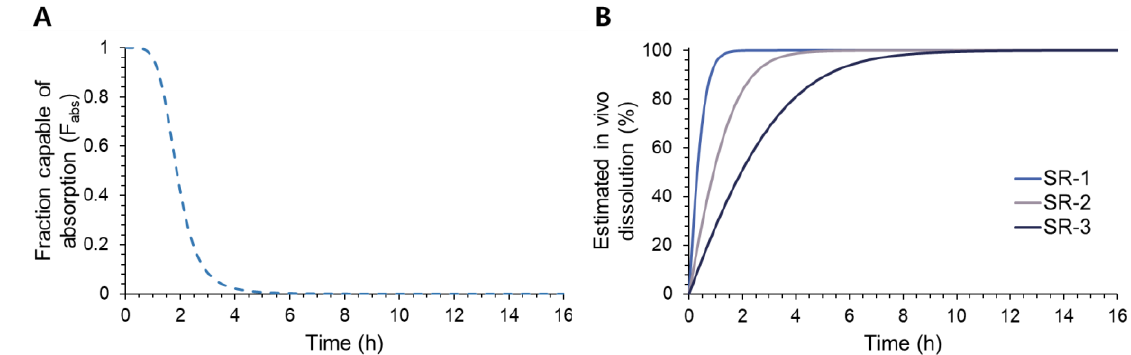
Figure 5. Changes in the fraction capable of absorption (F abs ) of donepezil ( A ) and the in vivo dissolution profiles of SR-1, SR-2, and SR-3 tablets ( B ).